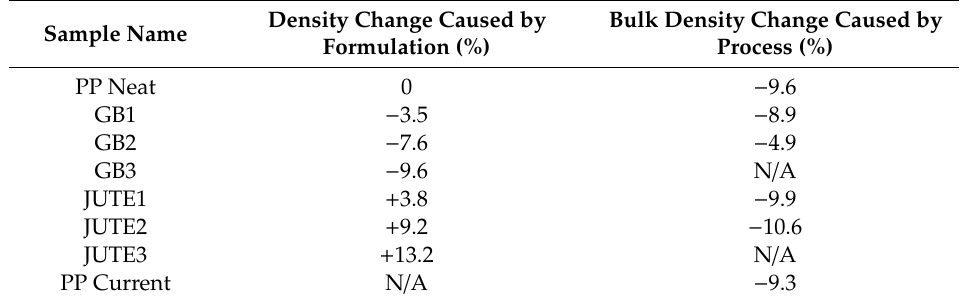
Figure 2. Normalised densities for PP Neat and different compounds using conventional and MuCell ® injection moulding. Note: The zero-length error bar in this figure is due to identical values of the density for each of the three specimens. Table 3. Normalised density changes as a result of a change in formulation and switching from conventional to MuCell ® injection moulding.